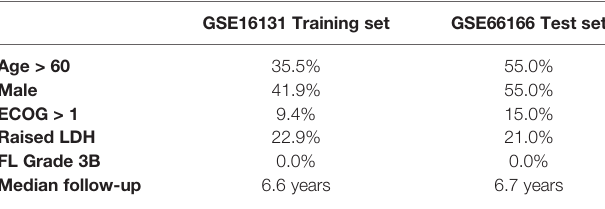
TABLE 1 | Baseline characteristics of the two cohorts. Adopted from Pastore et al. (9) and Dave et al.